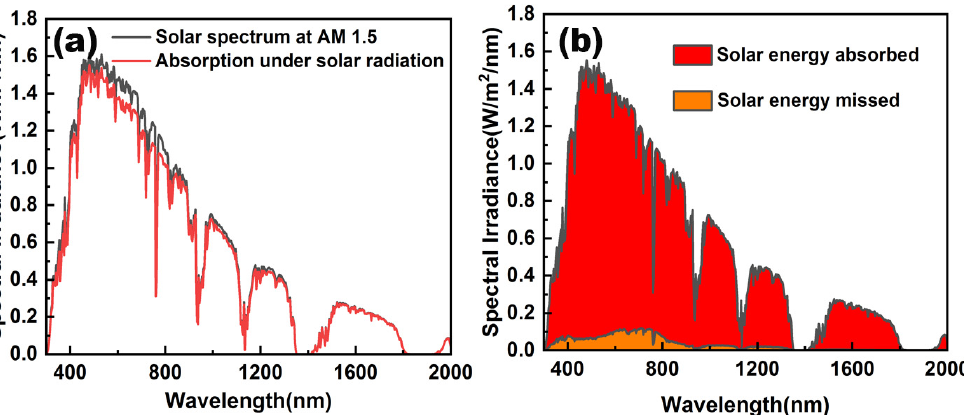
Figure 12. ( a ) Comparison of the AM 1.5 standard spectrum of solar radiation and the absorbed spectrum. ( b ) The energy absorbed and lost by the absorber under AM 1.5. spectrum. ( b ) The energy absorbed and lost by the absorber under AM